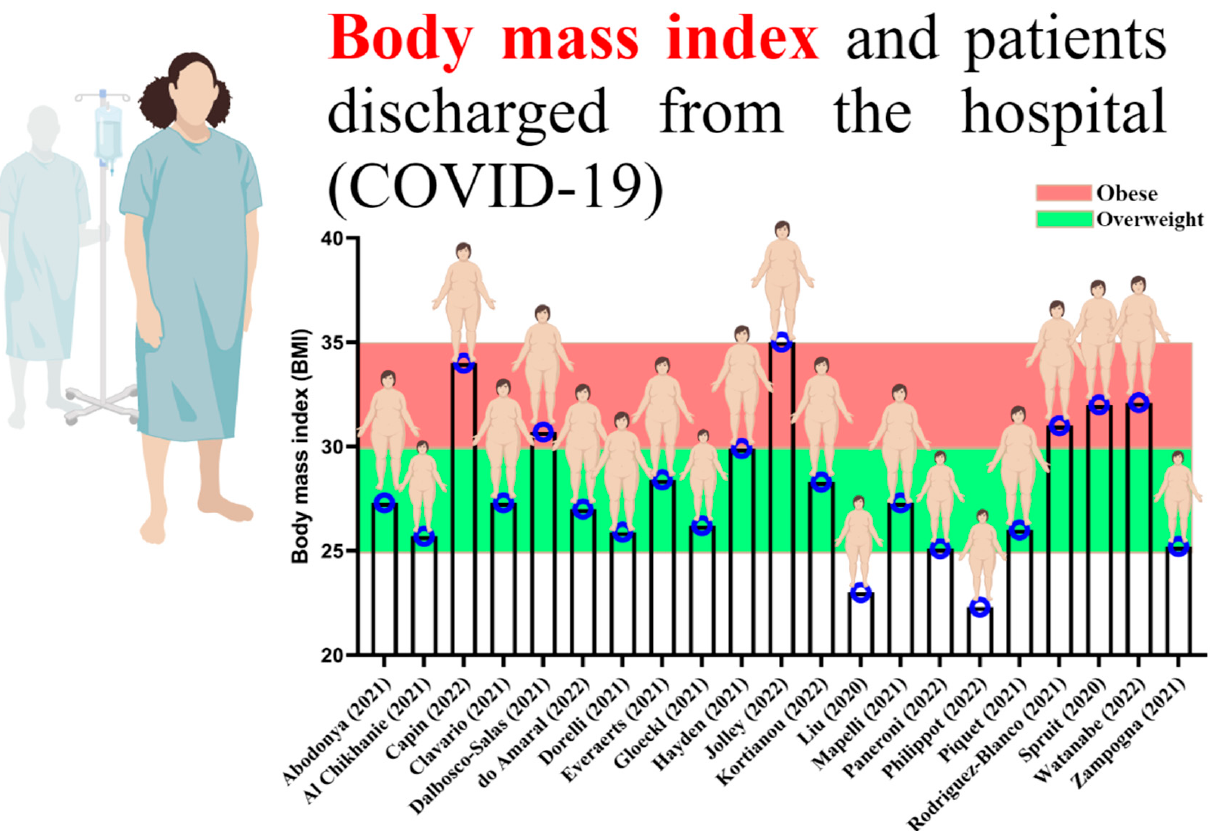
Figure 2. Body mass index of patients with COVID-19 discharged from the hospital [37–57].